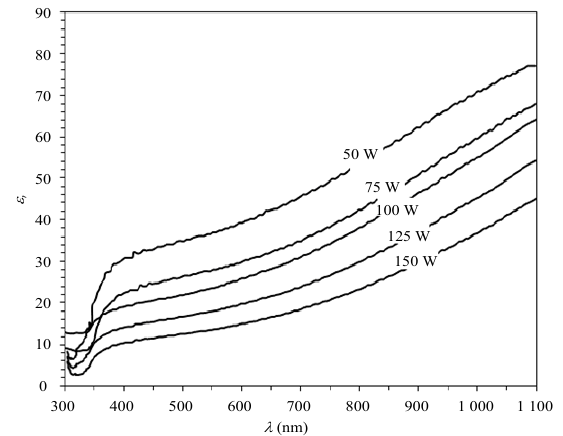
Fig. 7 Dielectric constant real as a function of wavelength for (Ti6Al4V) thin film at different working RF powers.